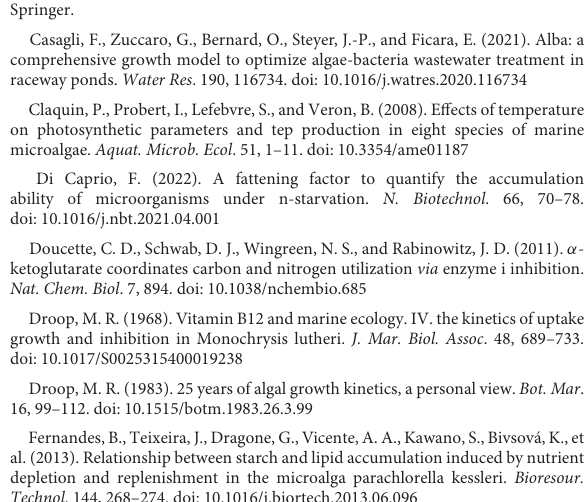
SUPPLEMENTARYFILES1 Scilab code for model